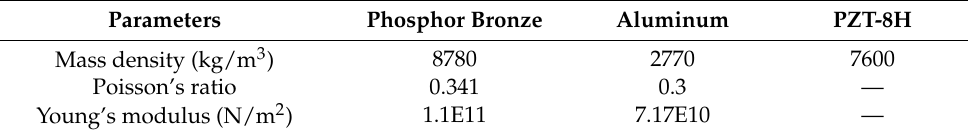
Table 2. Materials attribute of